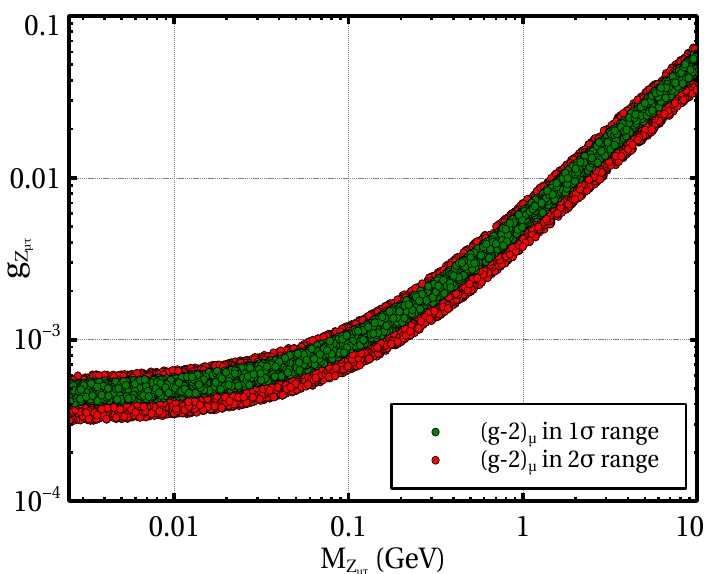
Figure 5 . Allowed region in g Z (SM) prediction and experimental result in 1 (cid:27) (green coloured points) and 2 (cid:27) (red coloured points) ranges